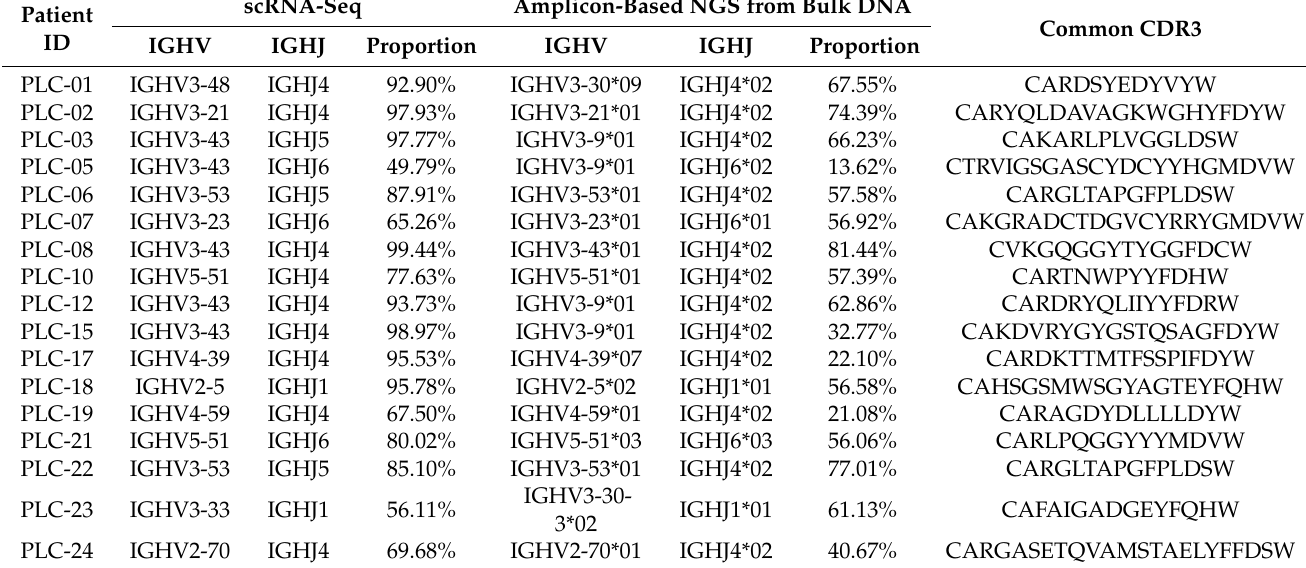
Table 1. Comparison of V(D)J clonal rearrangements at IGH locus identified by scRNA-seq and amplicon-based NGS from bulk DNA in the 17/19 samples in which the two methods gave matching results.